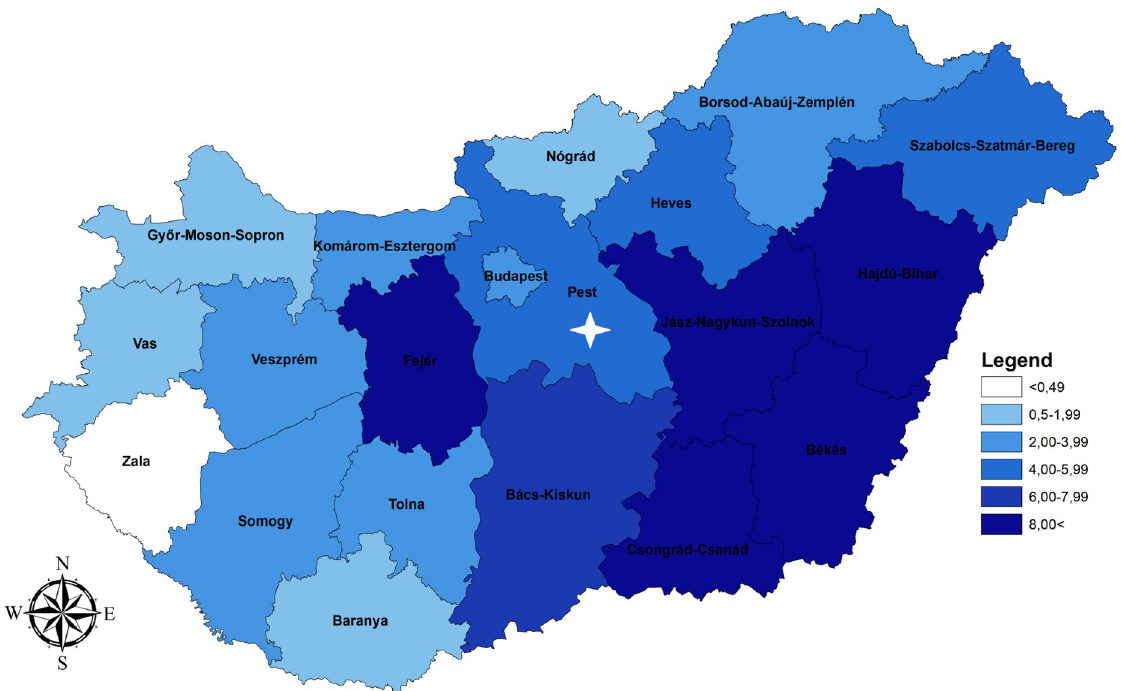
Fig 2. Geographical distribution of the West Nile virus cumulative incidence data at NUTS 3 level in Hungary between 2004 and 2019. NUTS 3 region where acute human Usutu virus infection was detected in 2018 is indicated by white asterisk.